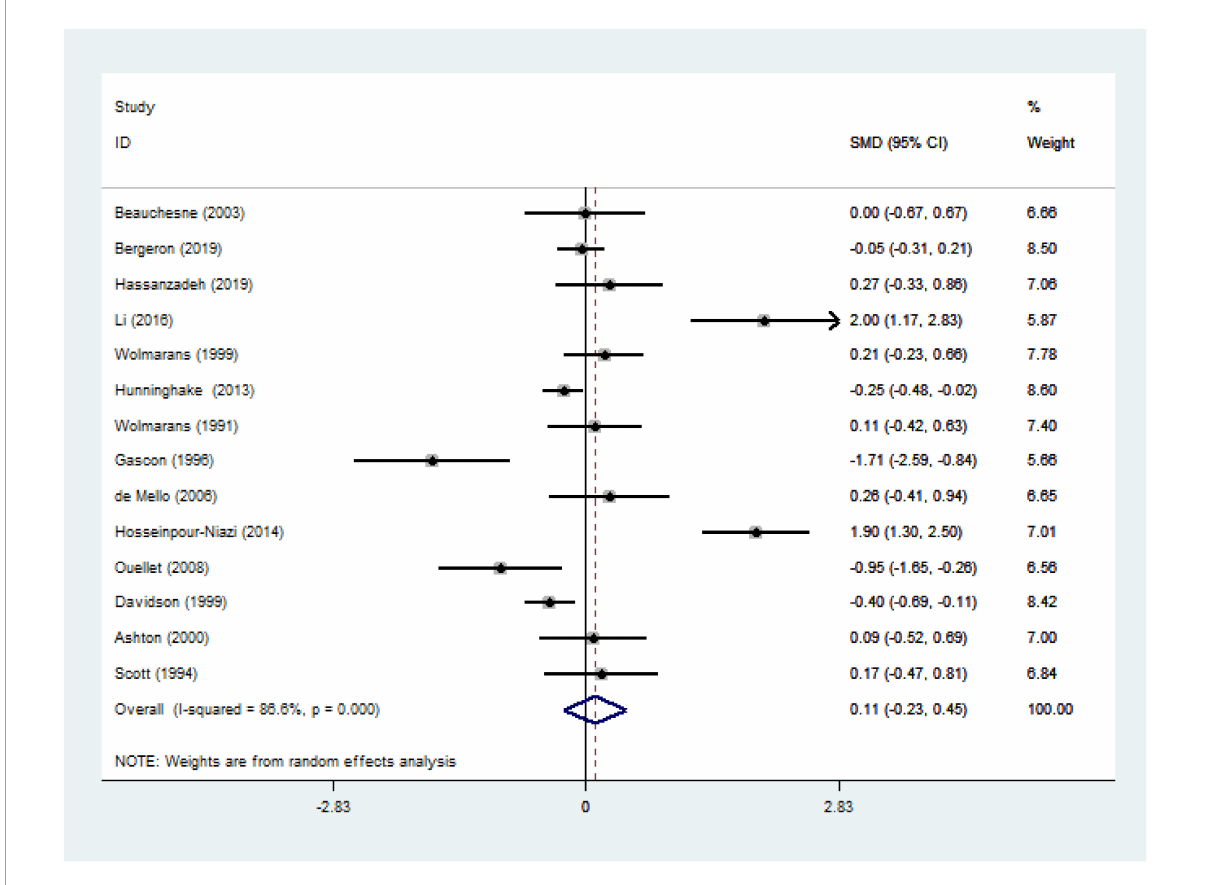
FIGURE6 Effect of red meat consumption on LDL-C concentration. LDL-C, low-density lipoprotein